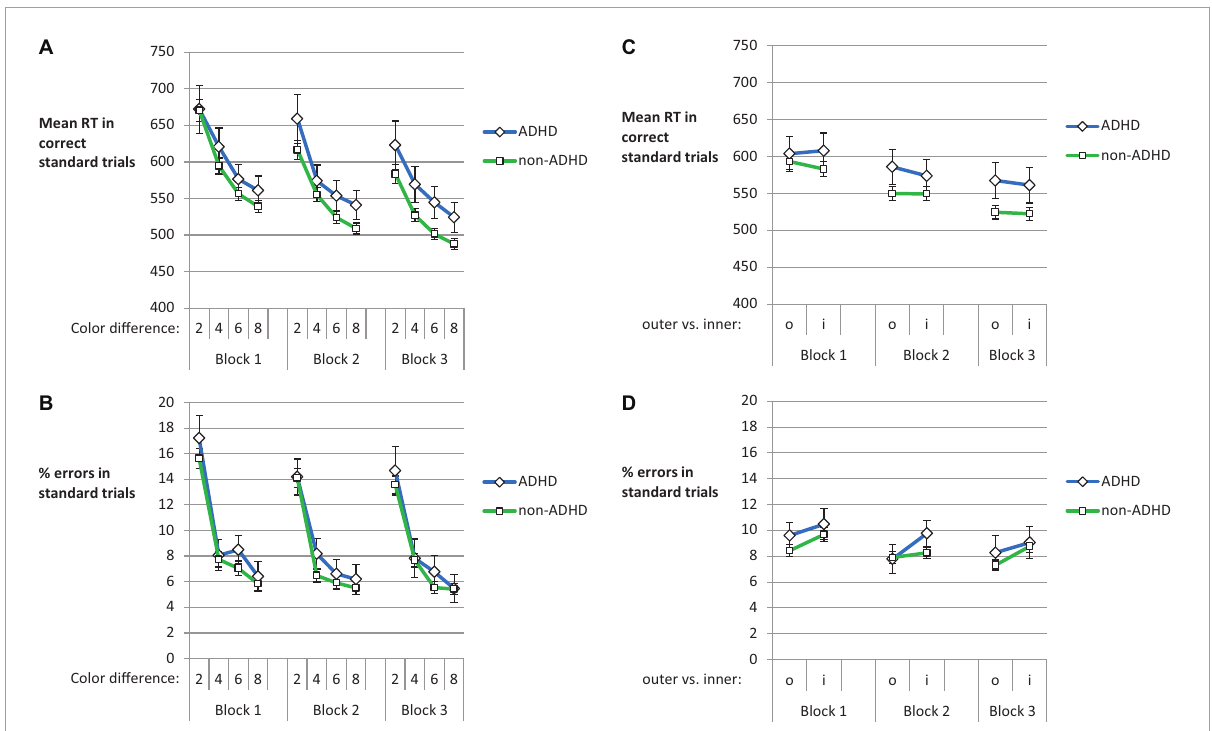
% position-following in ambiguous trials from the last practice block to the test block. We analyzed this with an ANOVA on percent position responses in ambiguous trials in Blocks 3 and 4 and Group. There was only a significant main effect of Block, = 0 . 024. There was neither a main F (1,243) = 5.86, p = 0.016, η 2 p effect of Group nor an interaction ( F s <